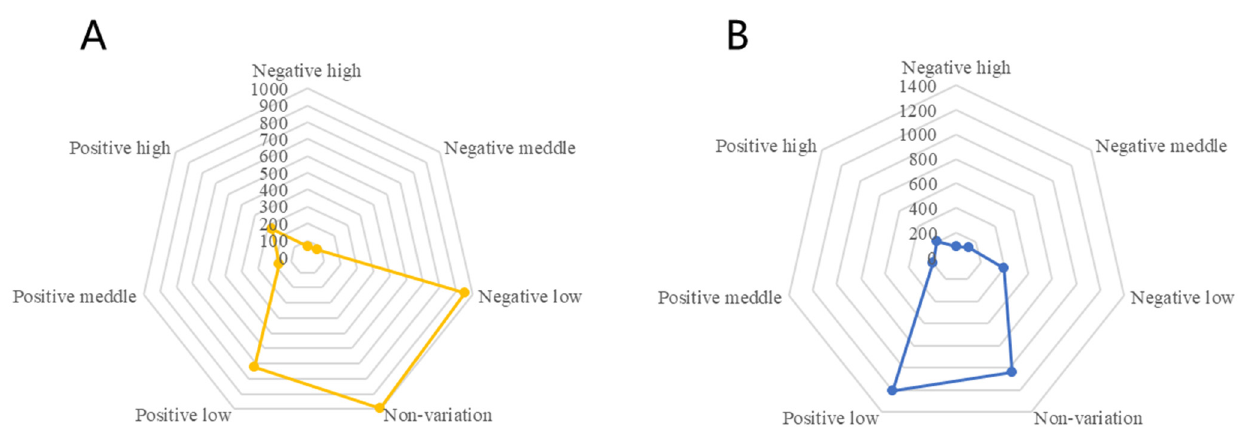
Figure 4. The spatial pattern of variation in cultivated land or rural residential land between 2009 and 2018 (( A ): cultivated land, ( B ): rural residential land). Table 3. The proportion of matching modes distribution between 2009 and 2018.